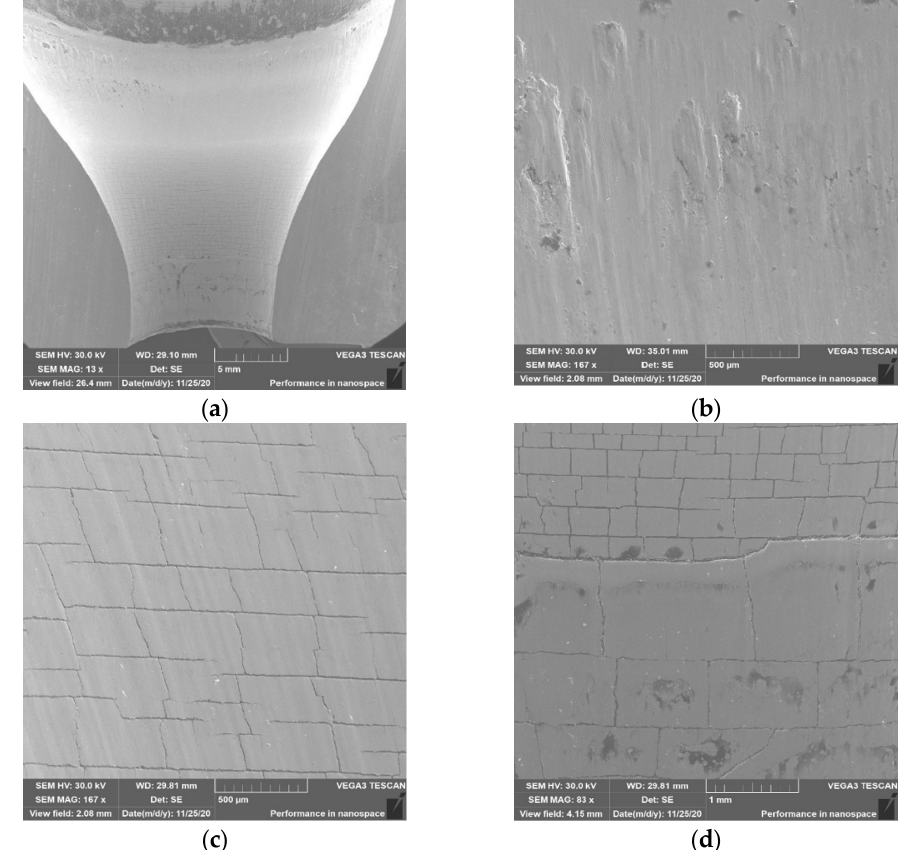
Figure 16. SEM analysis for tool 4: ( a ) cavity; ( b ) area in zone 1; ( c ) area in zone 2; ( d ) area in zone 3.